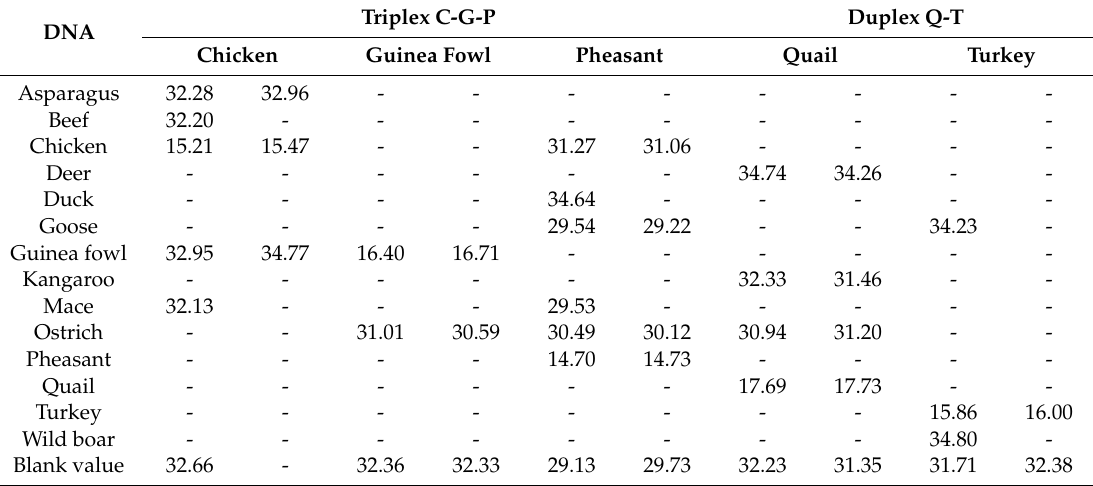
Table 3. Cq values for various animal and plant species tested with the triplex real-time polymerase